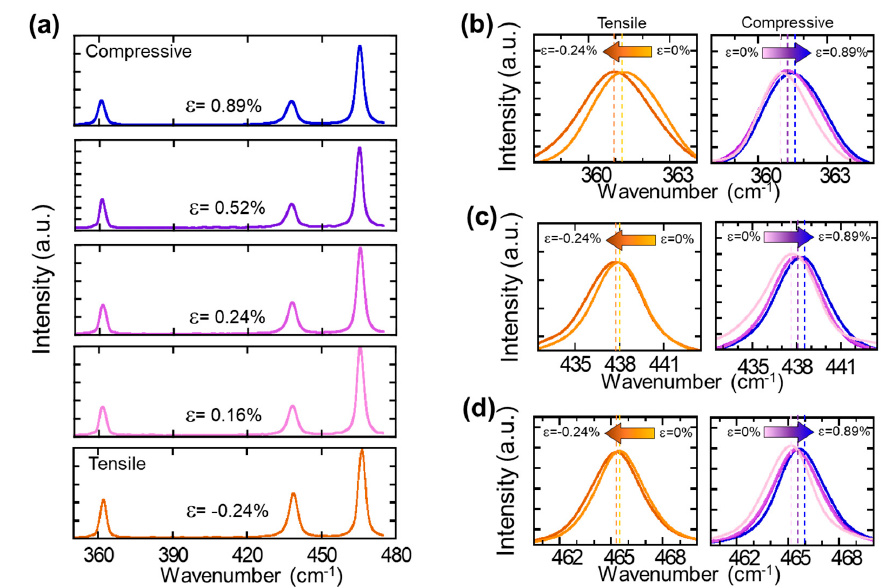
Figure 5. ( a ) Raman spectra of BP measured under uniaxial strains of up to 0.89% of the tensile strain (for the convex mold) and up to 0.24% of the compressive strain. ( b – d ) Magnified Raman spectra of the A g1 , B 2g , and Ag 2 Raman modes as a function of the applied strain.